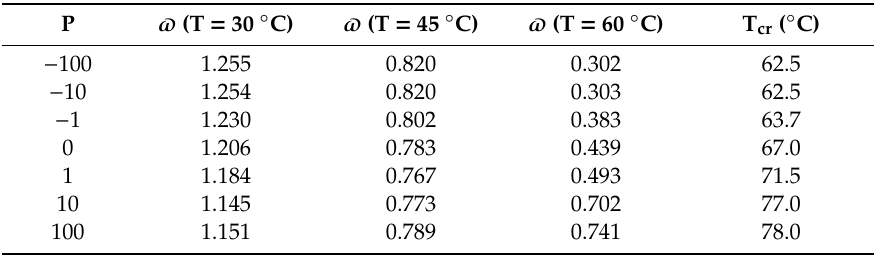
Table 3. Natural frequency and critical buckling